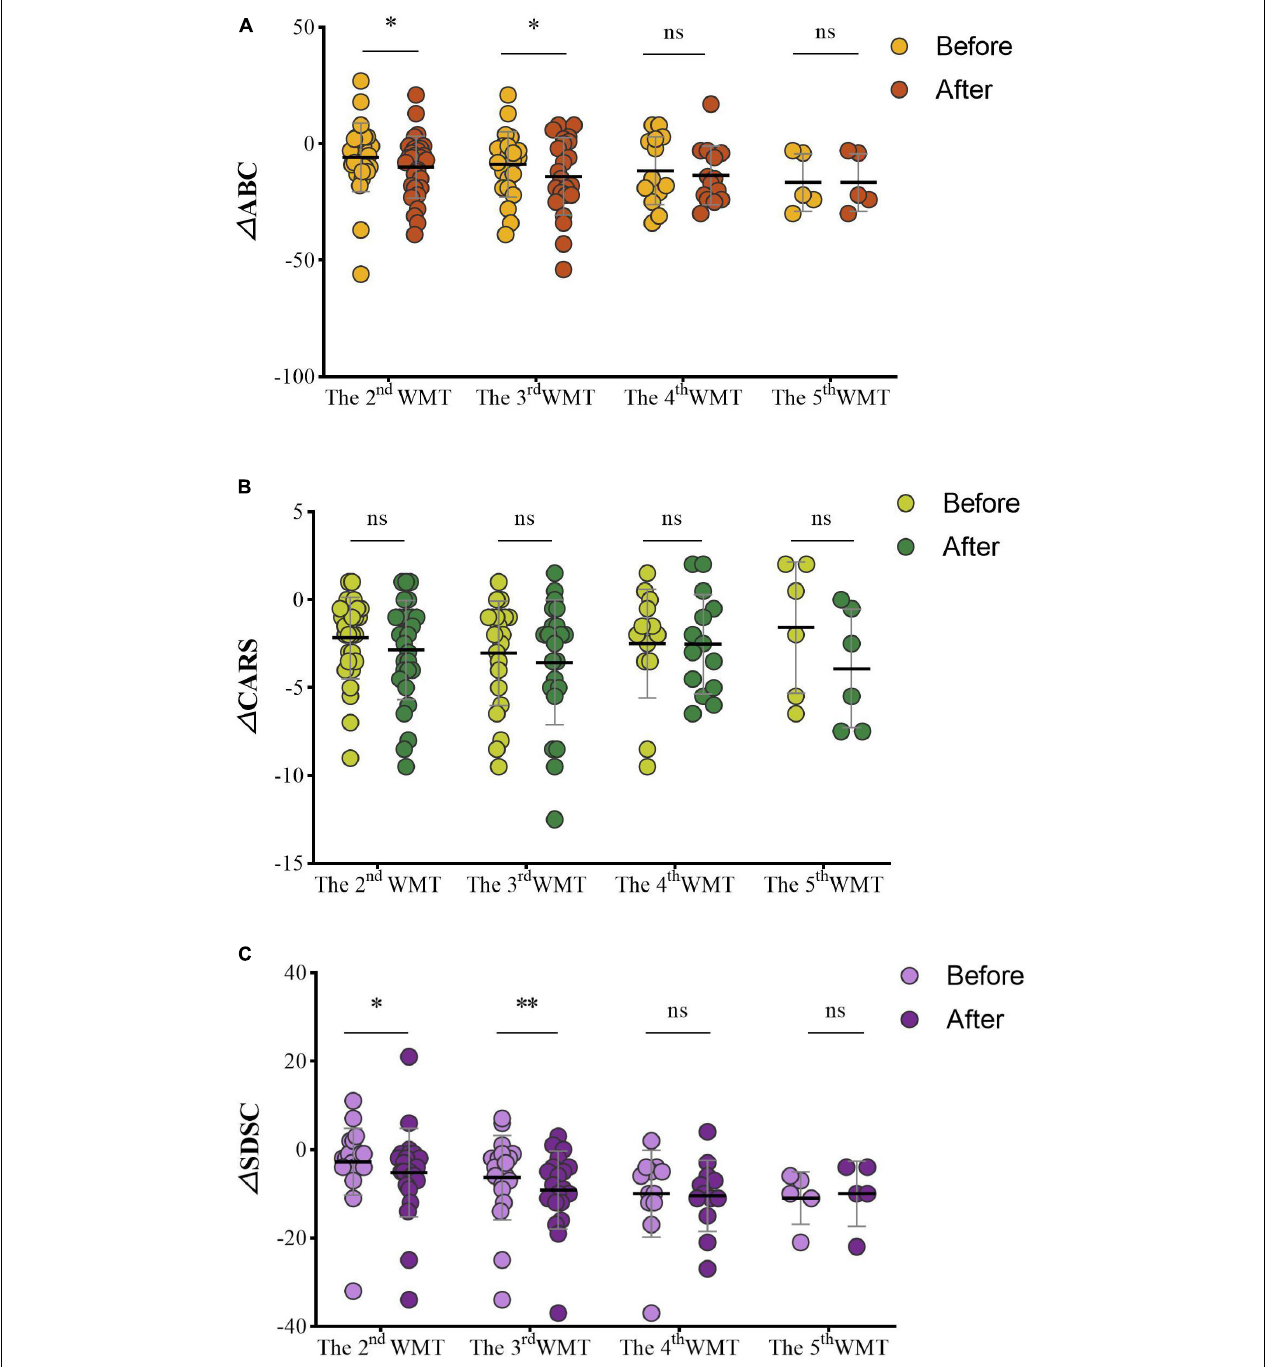
FIGURE 5 | Effect of different numbers of WMT courses on the ABC (A) , CARS (B) , and SDSC (C) . (cid:77) ABC: the ABC after WMT minus ABC at primary baseline; (cid:77) CARS: the CARS after WMT minus CARS at primary baseline; (cid:77) SDSC: the SDSC after WMT minus SDSC at primary baseline. ABC, Aberrant Behavior Checklist; CARS, Childhood Autism Rating Scale; SDSC, Sleep Disturbance Scale for Children; WMT, washed microbiota transplantation. Paired Student’s t -tests and Wilcoxon signed-rank tests were used to compare the data. ∗ P < 0.05; ∗∗ P < 0.01; ns P > 0.05 not significant.